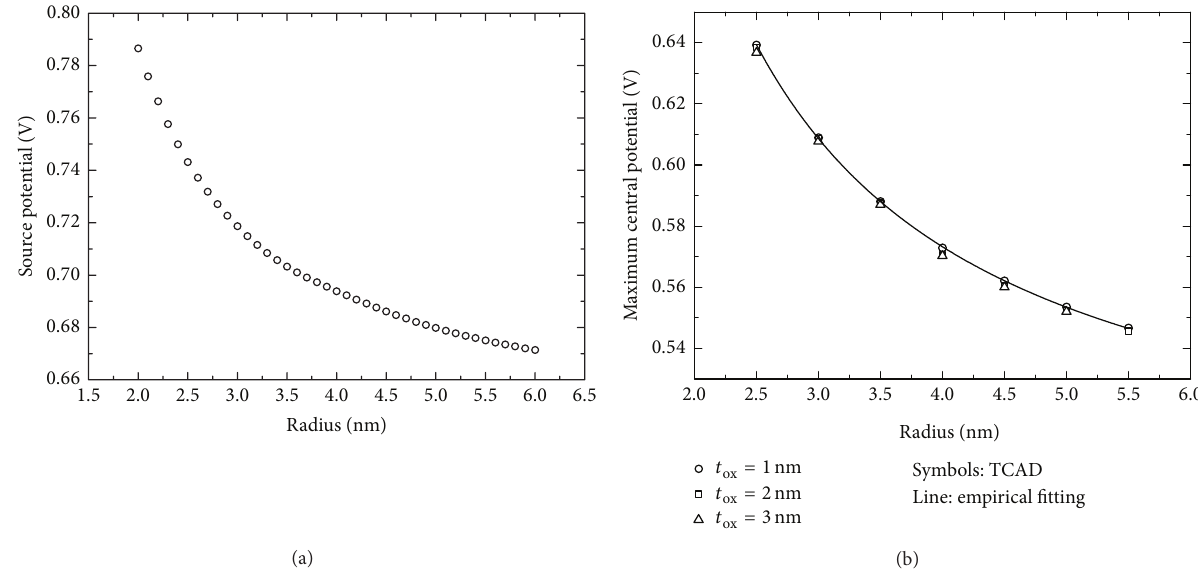
Figure 2: (a) Dependence of source potential on the nanowire radius for the source doping density shown in Table 1. (b) Dependence of maximum central electric potential on the nanowire radius. The results can be fitted empirically with a rational function.